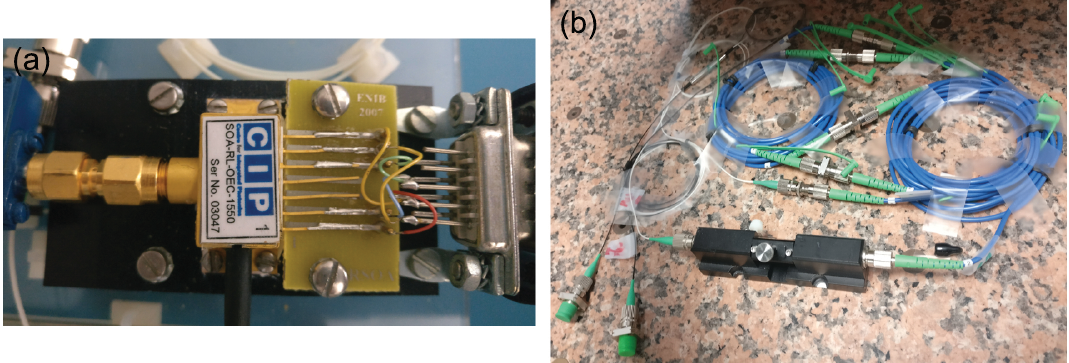
Figure 2. Photograph of ( a ) RSOA and ( b ) BFL modules used in the